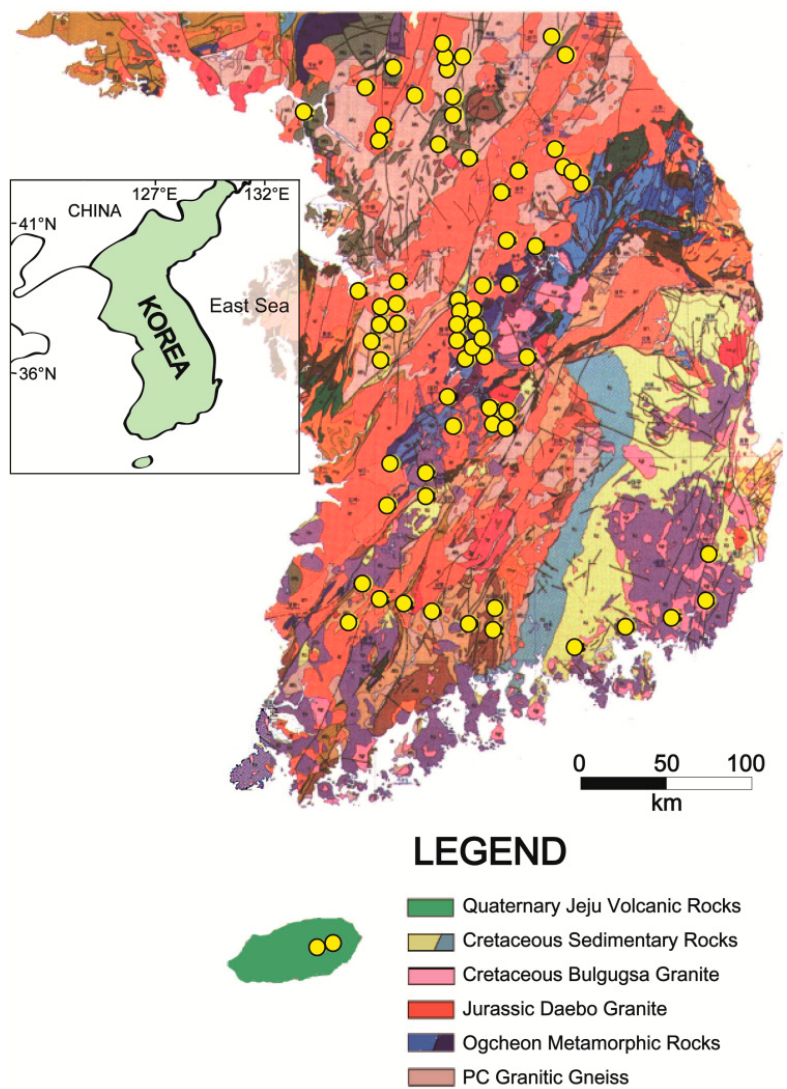
Figure 1. Location map of bottled water manufactures marked as yellow points on the geological map of